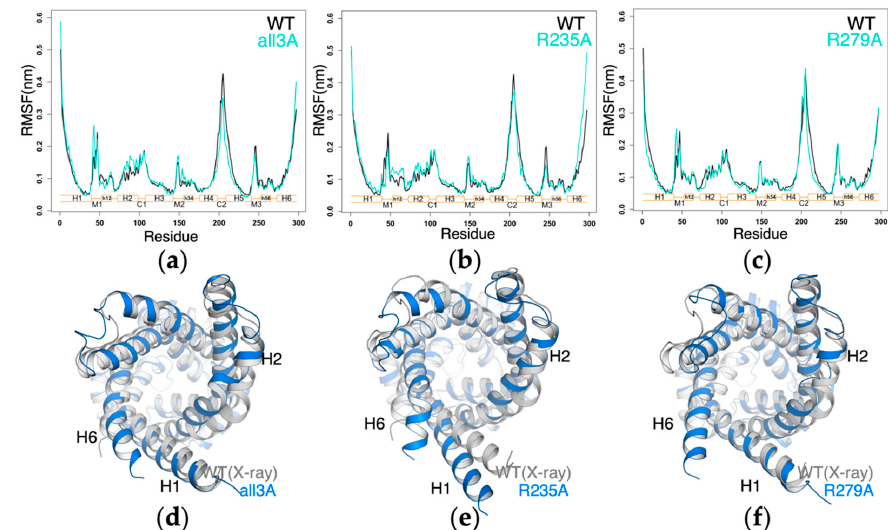
Figure 5. Structures and dynamics of AAC were not significantly affected in the all3A-AAC , R235A-AAC and R279A-AAC mutants. ( a – c ) RMSF of three mutants compared to that of wild-type AAC . The RMSF were calculated on each trajectory from 200 ns to 1 µ s. ( d – f ) Superposition of the structures at the end of the simulation (1 μ s) to the crystal structure (PDB:1OKC). In R79A-AAC , significant structural changes were observed at the cytoplasmic side, so we extended the simulation to 1.5 μ s. In wild-type AAC , C1 loop is much more stable than C2 loop as reflected by the much lower RMSF values (Figure 6a), and a major stabilizing factor is the strong D195(H4):R104(C1 loop) salt bridge that attaches C1 loop to H4 (Figure 6b). This salt bridge is extremely stable in the simulations of wild-type AAC , but it became much more dynamic in R79A-AAC (Figure 6c). Therefore, the C1 loop together with cytoplasmic sides of H2 and H3 helices are much more flexible in R79A- AAC as reflected by the dramatic increase in the RMSF values of this region (Figure 6a). Starting at 1193 ns, the dynamic R104:D195 salt bridge completely separated (Figure 6b), forming a big crevice between the cytoplasmic halves of the H3 and H4 helices in R79A- AAC trajectory (Figure 6d). Moreover, drastic and dynamic distortions are observed within the helix backbone of H3, which is also reflected by the big difference of RMSF values for the H3 region in R79A-AAC and in wild-type AAC (Figure 6a).